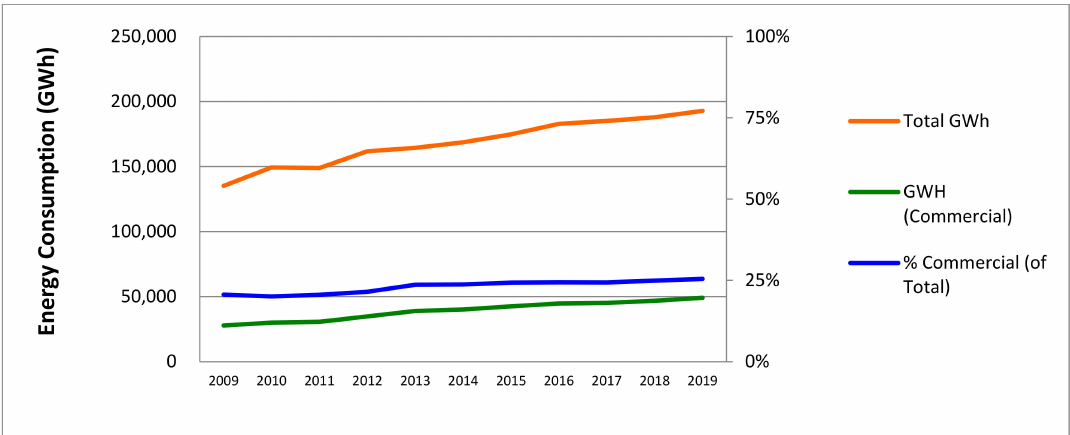
Figure 1. Total electricity consumption and electricity consumption of the commercial building sector in Thailand 2009– 2019